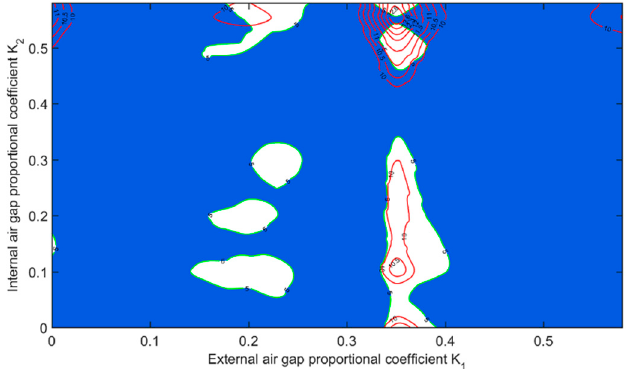
Figure 10. The contour of the average torque in the feasible region X. Figure 8. The contour of the average torque in the feasible region X. Energies 2020 , 13 , x FOR PEER REVIEW